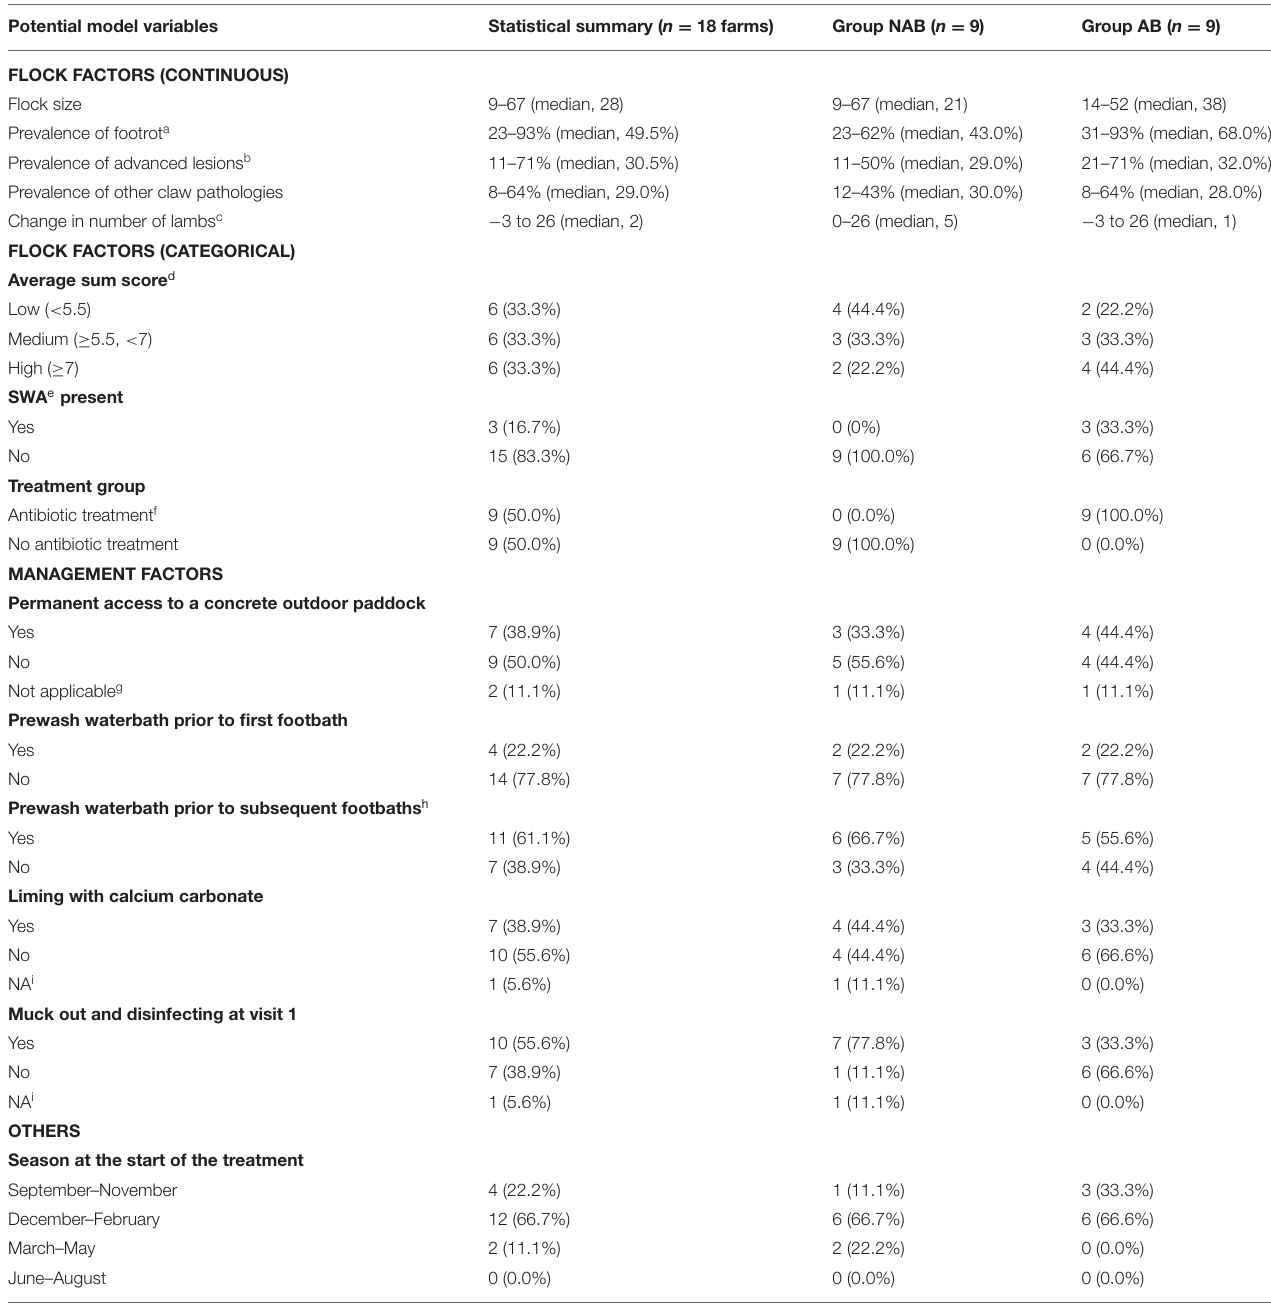
TABLE 2 | Definition of factors potentially affecting the number of footbaths needed for complete elimination of virulent footrot in Swiss sheep